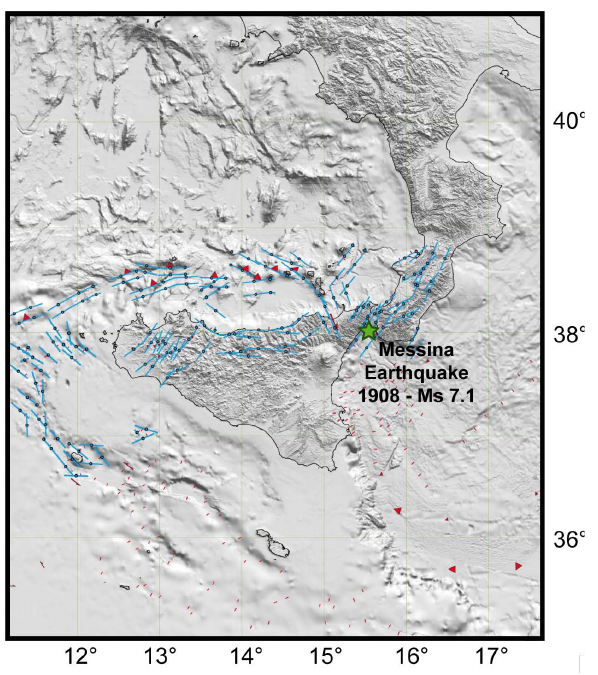
Fig. 10. Location of the epicenter of the 1908 Messina earthquake (green star), superimposed on the simplified fault base of 25km length segments for the Sicily–Calabria region. Each blue segment (with a black dot in its middle) represents the top edge of each 25 × 20km unit source function stored in the precomputed database.